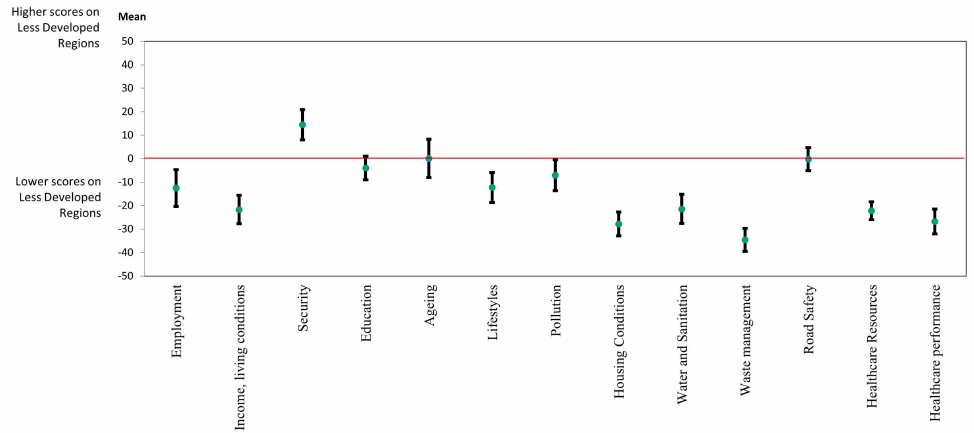
Figure 3. Mean di ff erences between less developed (LD) regions and more developed (MD) regions, by dimensional sub-index. Note: The interval plots display 95% confidence intervals (CI) for each mean di ff erence. Each dot represents the value of the mean di ff erence in each dimensional sub-index: negative values in a dimension (below 0) indicate that LD regions perform worse than MD regions in that dimension; positive values in a dimension (above 0) indicate that LD regions perform better than MD regions in that dimension. If an interval does not contain 0, the corresponding means are significantly di ff erent.